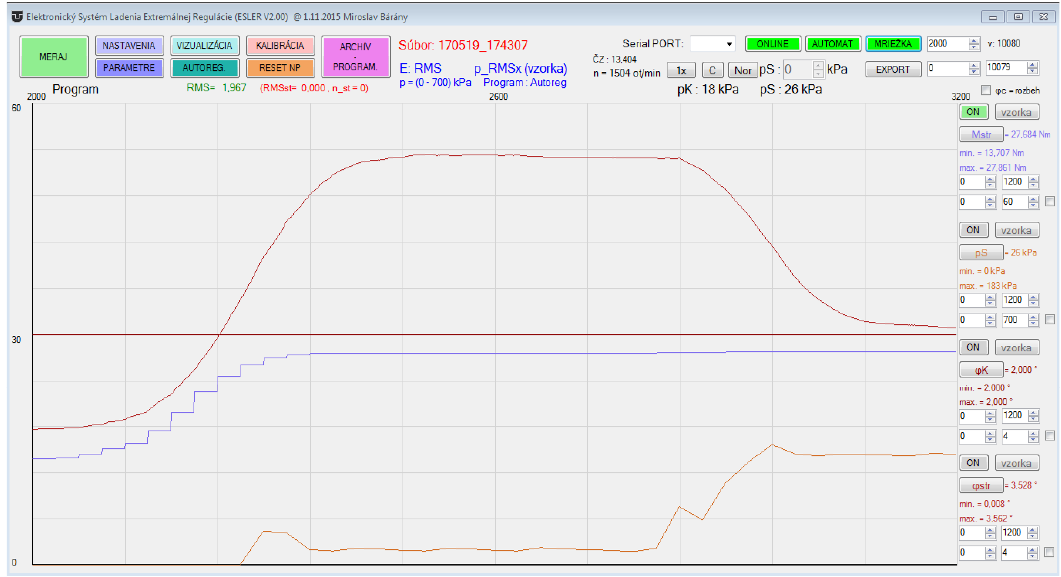
Figure 11. The graphical user interface of the electronic constant twist angle control